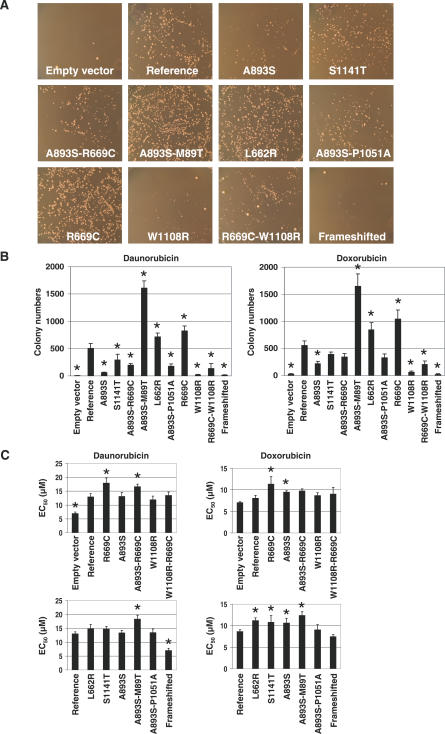
Alterations in Resistance of P-Gp Variants to Daunorubicin and Doxorubicin(A) Drug resistance of P-gp variants measured with a plating assay on solid medium. Cultures from each strain were adjusted to the same cell concentration and spread on plates carrying daunorubicin (27.5 μM) or doxorubicin (12.5 μM). Yeast expressing P-gp variants survived on these high-concentration drug plates to varying degrees. Daunorubicin plates for each of the P-gp variants are presented. The corresponding plates for doxorubicin showed similar variability.(B) Drug resistance of P-gp variants represented by colony numbers surviving on the high-concentration drug plates. Each value represents the average ± standard deviation of three measurements. The values with significant differences (p < 0.05) are marked with *.(C) Drug resistance of P-gp variants in liquid medium. Each EC50 value represents the average ± standard deviation of three or four measurements. The values with significant differences (p < 0.05) are marked with *.